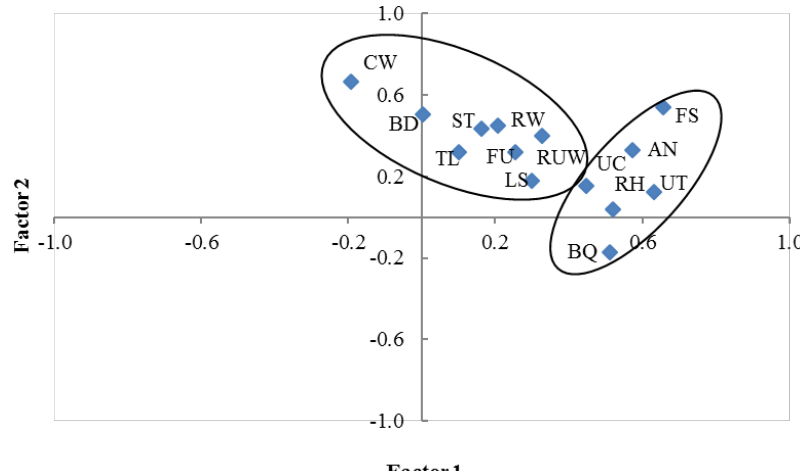
Figure 2. Extracted factors after varimax rotation. ST, stature; TL, top line; CW, chest width; BD, body depth; LS, loin strength; RW, rump width; BQ, bone quality; FU, fore udder attachment; RH, rear udder height; RUW, rear udder width; UT, udder texture; UC, udder cleft; AN, angularity; FS, final